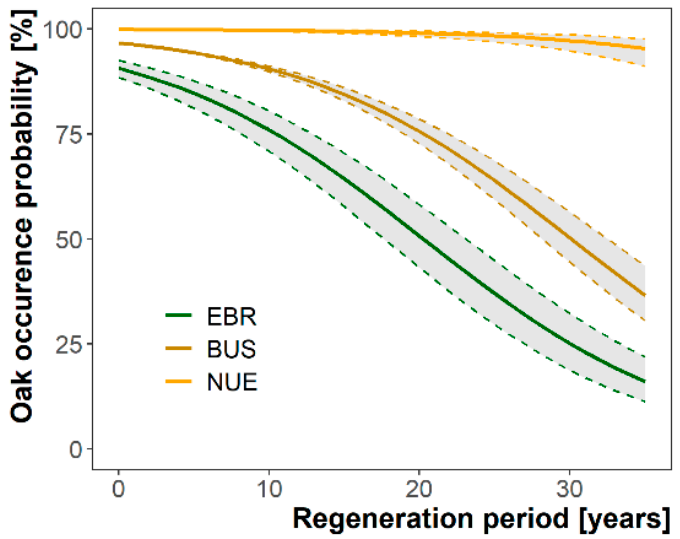
Figure 2. Estimated occurrence probability of oak for the studied sites depending on the regeneration period (Equation (2); for model statistics see Table S2). Table 4. Model statistics for tree density as a function of regeneration age (A) (Equation (3)); the reference tree species is oak; Est—estimated value; SE—standard error; p — p -value; significant values are written in bold.